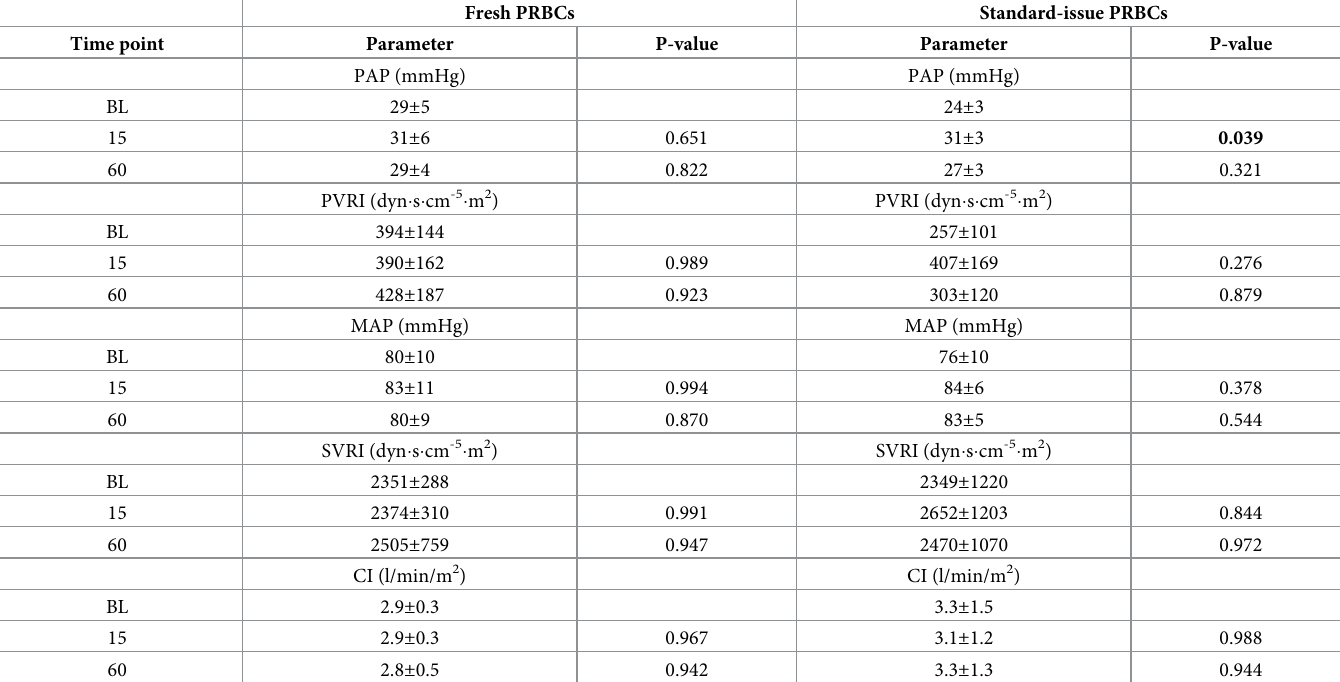
Table 2. Hemodynamic parameters at baseline, and within 15 minutes and 60 minutes after transfusion. P-values (Welch’s t-Test) indicate differences versus baseline within each group. Abbreviations: BL, baseline; CI, cardiac index; MAP, mean arterial pressure; PAP, pulmonary arterial pressure; PRBC, packed red blood cells; PVRI, pulmonary vascular resistance index; SVRI, systemic vascular resistance index.